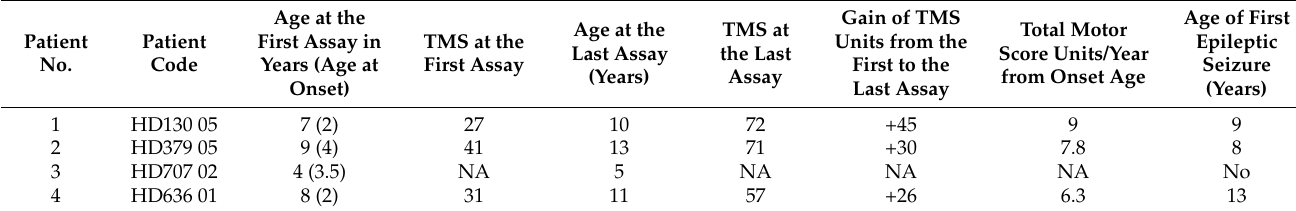
Table 2. First developmental steps.